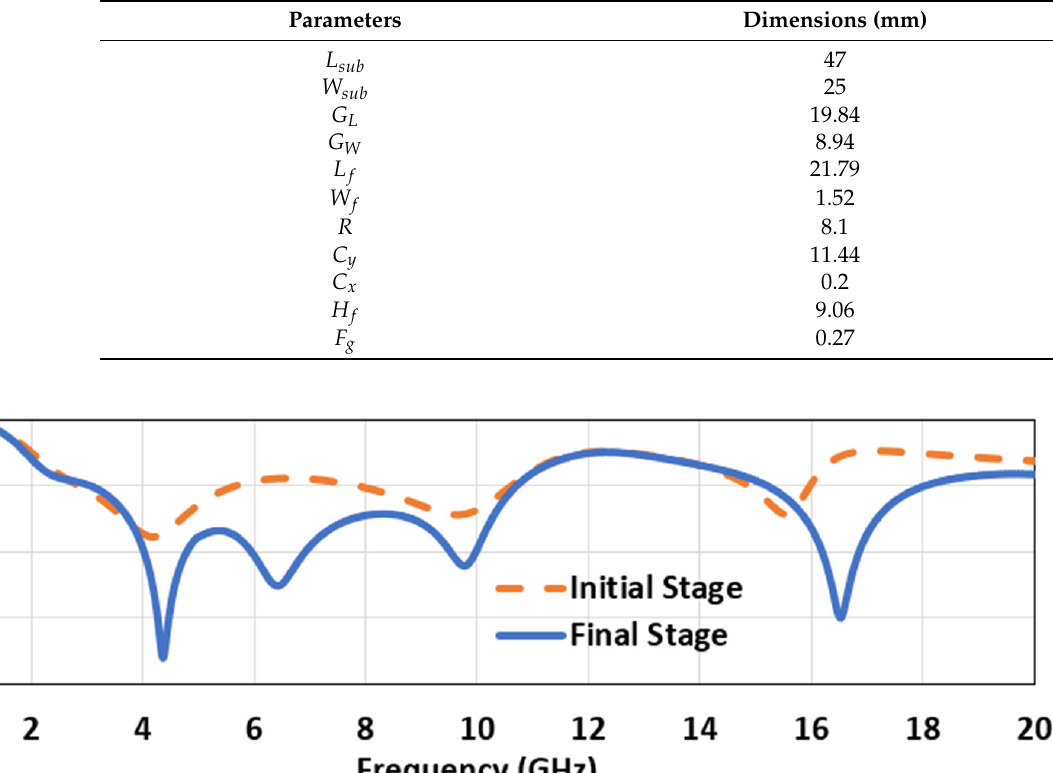
Figure 1. The evolution of the proposed antenna design, with dimension variables ( a ) Initial stage, ( b ) Final stage and ( c ) Dimensions variables of the proposed antenna. Table 2. The proposed free-space antenna dimensions.